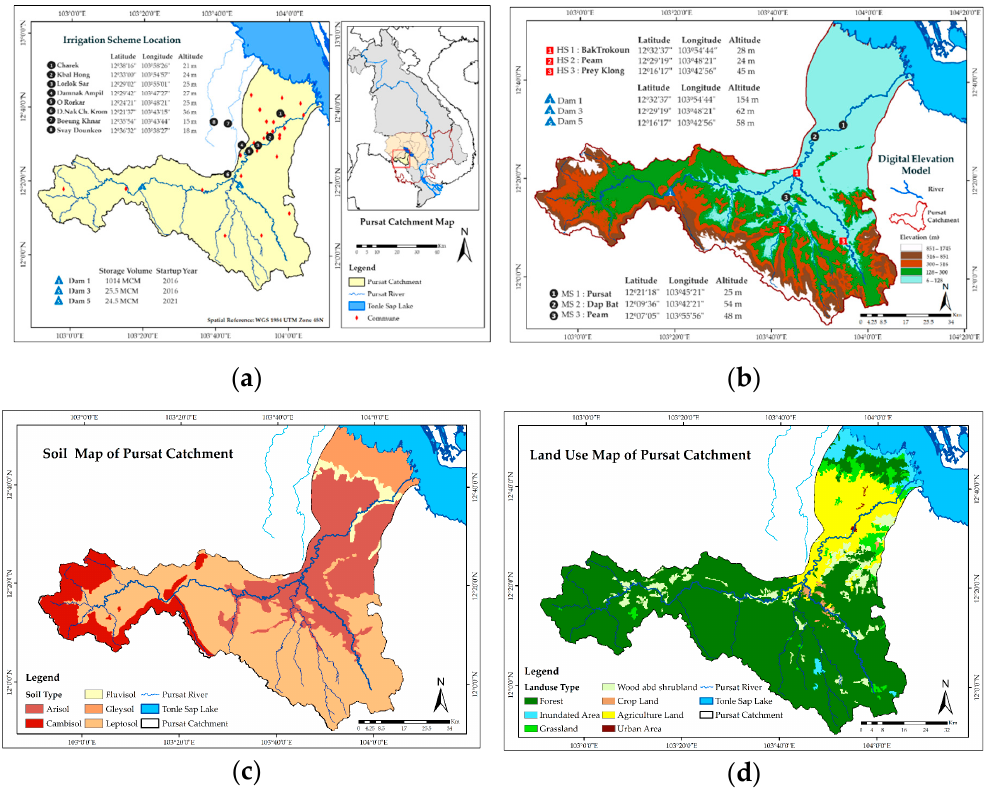
Figure 1. ( a ) Study area with dam and irrigation scheme location, ( b ) digital elevation model with hydrological and meteorological station, ( c ) soil type, ( d ) land use/land cover of PRB.